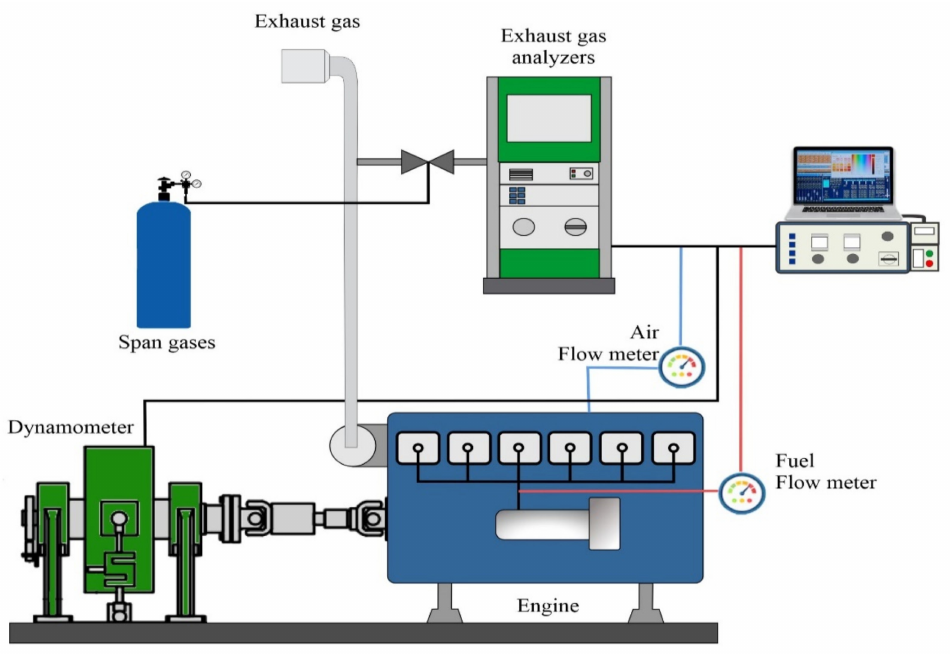
Figure 4. Typical engine dynamometer testing setup